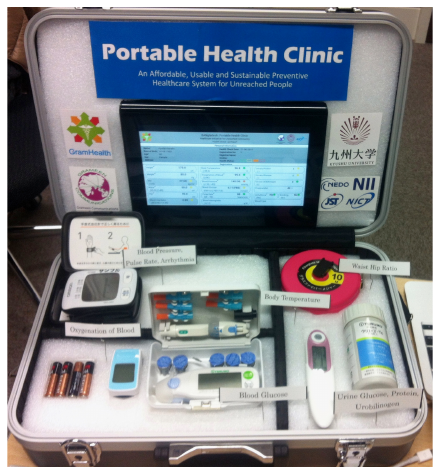
Figure 1. Sensors inside the Portable Health Clinic